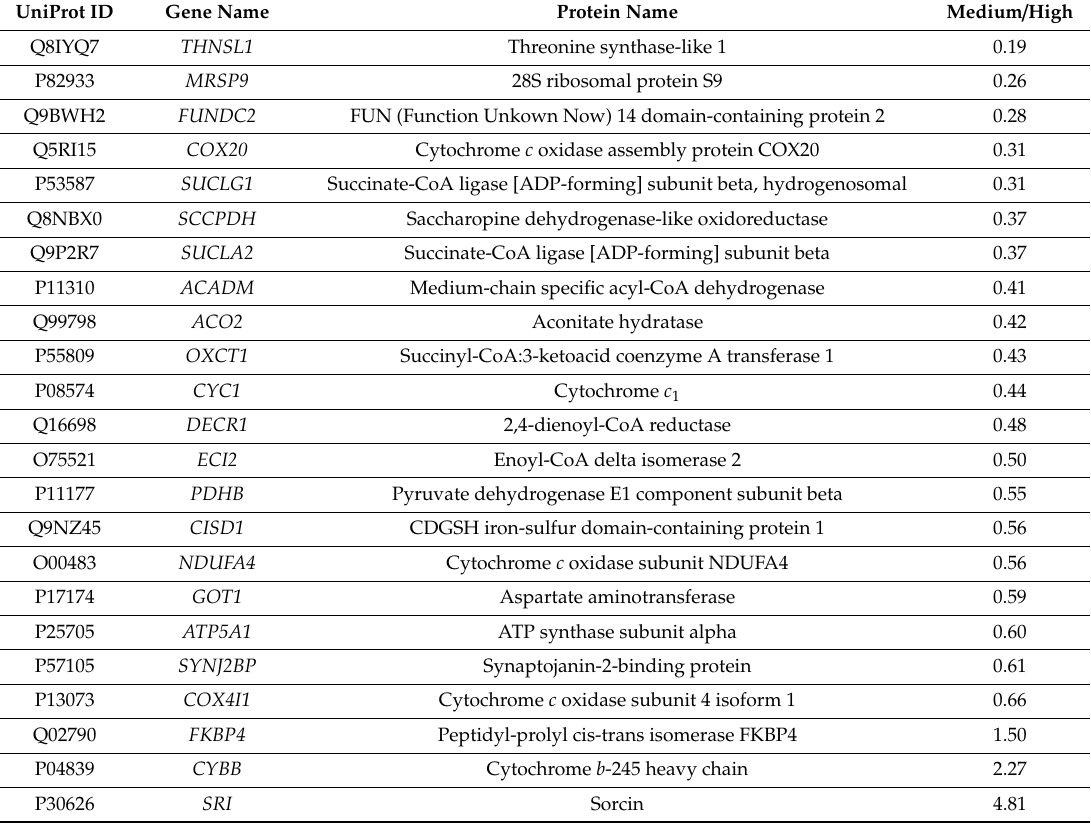
Table 1. Description of proteins involved in energy metabolism, which showed a significant p.value ( p < 0.05) in an unpaired, two tails t -test medium vs high. Results are expressed as ratios of protein levels of asthenozoospermics to